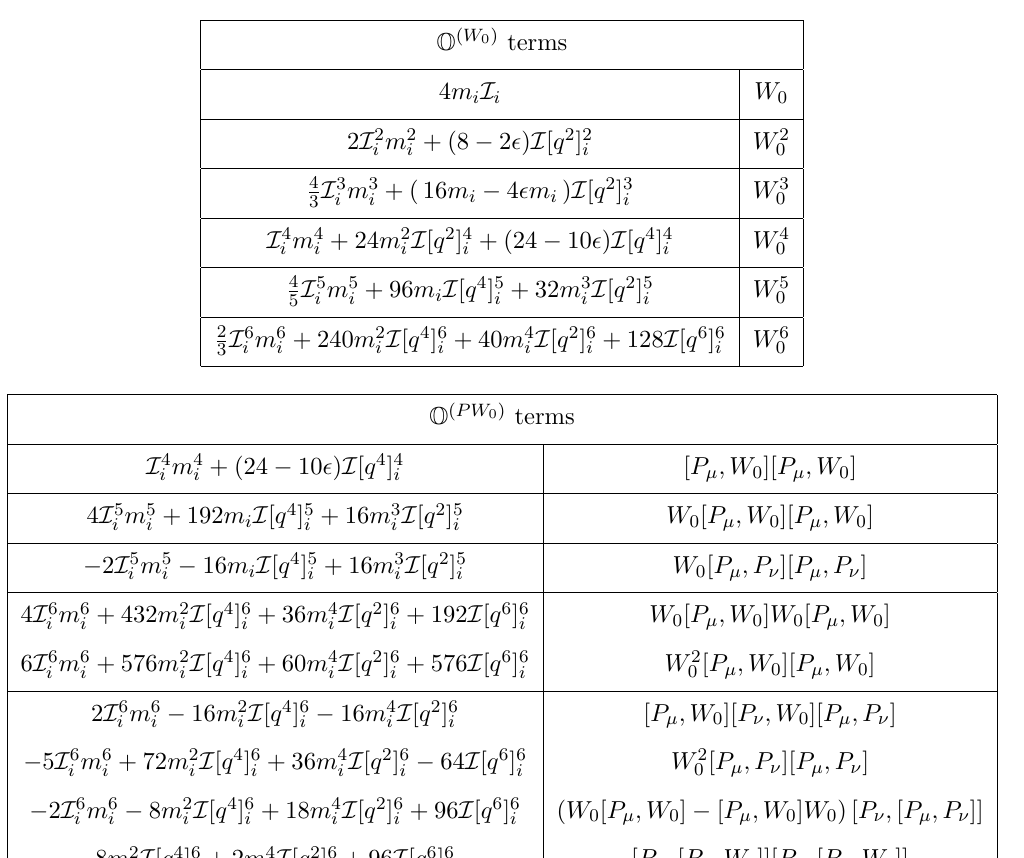
Table 4 . Pure gauge operator structures in the fermionic UOLEA.